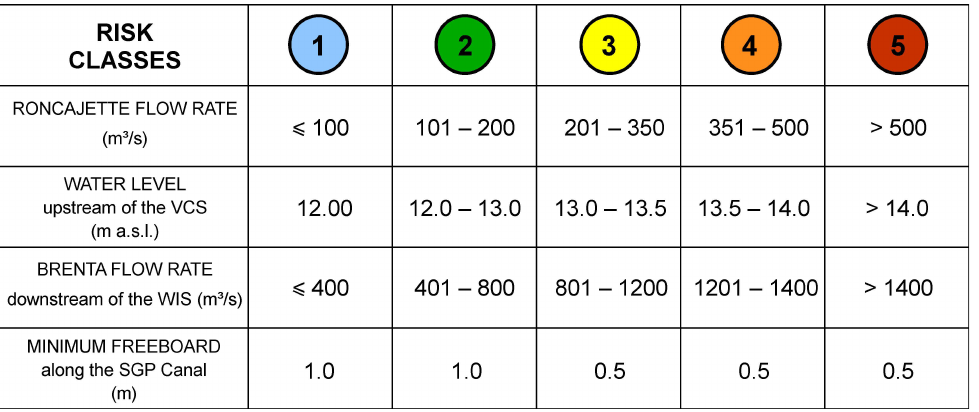
Figure 2. Definition of the five hydraulic risk classes in four branches of the Brenta–Bacchiglione river network—flow rate in the Roncajette River; water level upstream of the VCS; flow rate in the Brenta River downstream of the WIS; and minimum levee freeboard along the S. Gregorio-Piovego (SGP)